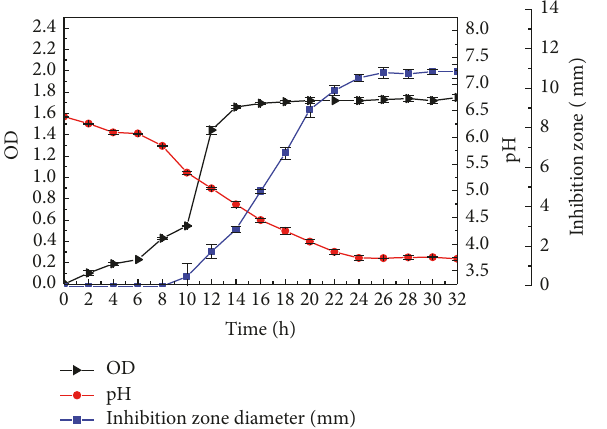
Figure 1: Relationship between the growth of the bacteriocinogenic strain and Enterocin Y31 production.